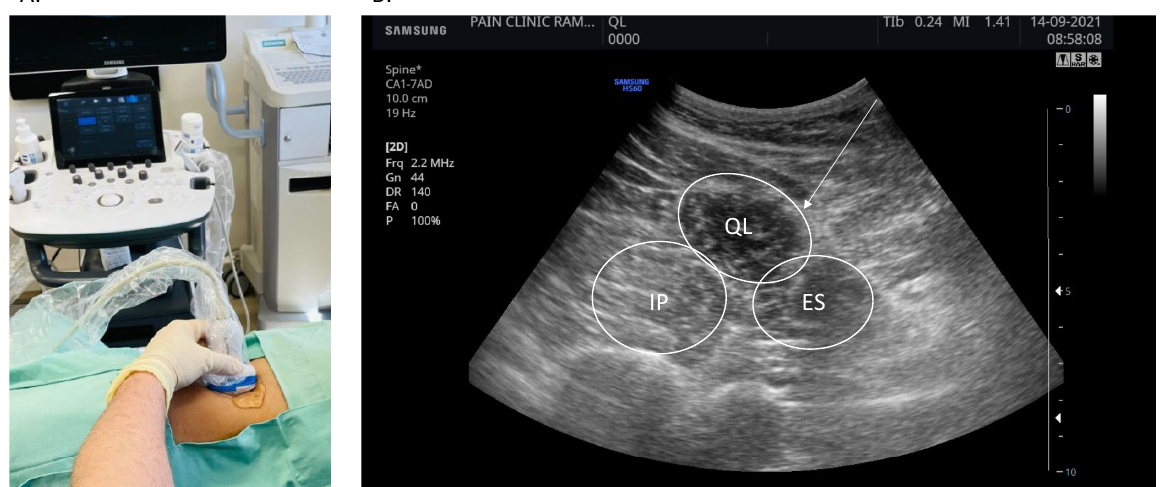
Figure 1. Ultrasound imaging and needling of the quadratus lumborum muscle. ( A ). Experimental setup demonstrating patient positioning in the lateral decubitus position and transducer placement. ( B ). A short-axis view of the quadratus lumborum (QL), iliopsoas (IP) and erector spinae (ES) in a healthy individual. The needle trajectory is highlighted. For clarity purposes a short-axis view is presented here; however, needling of the muscle was performed in long-axis.